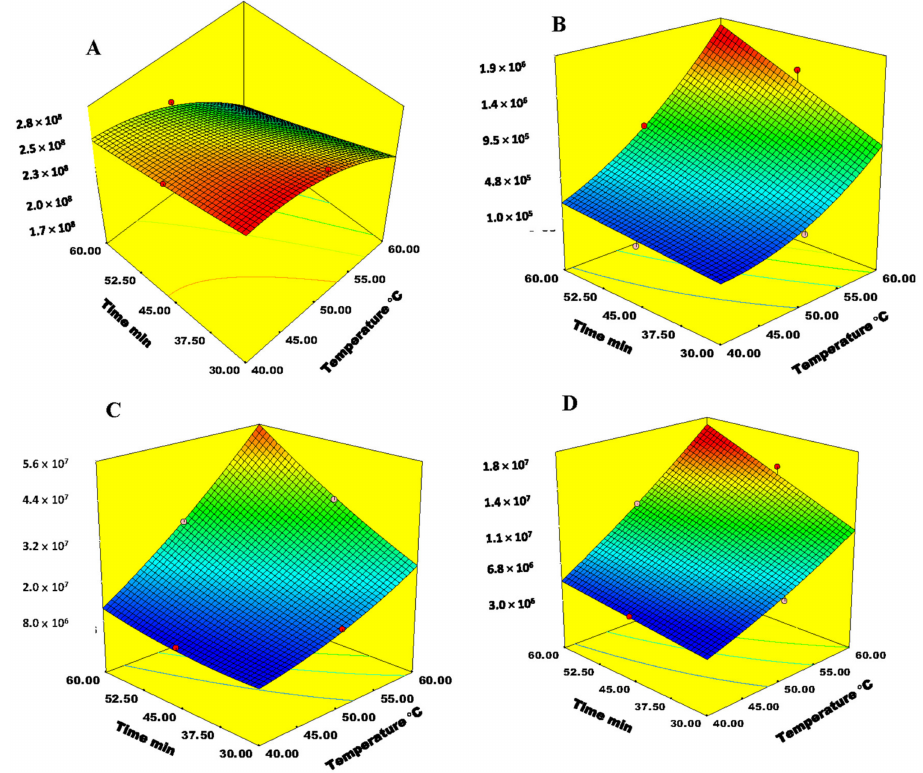
Figure 5. Response surface plot for interaction between extraction temperature and exposure time for bound ( A ) alcohols, ( B ) C13-norisporenoids, ( C ) monoterpenes and ( D )